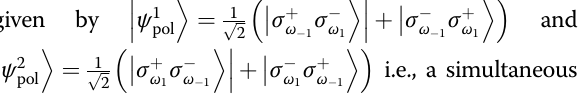
Fig. 5 Generation of hyper-entangled state. Generation of hyper- entangled state. Polarization entanglement along with the N - dimensional energy-entangled state is created by setting the quantization axis q of the atom to be perpendicular to the cavity axis. This choice enables only σ ± polarization excitations. The hyper- entangled state is given by Eq.